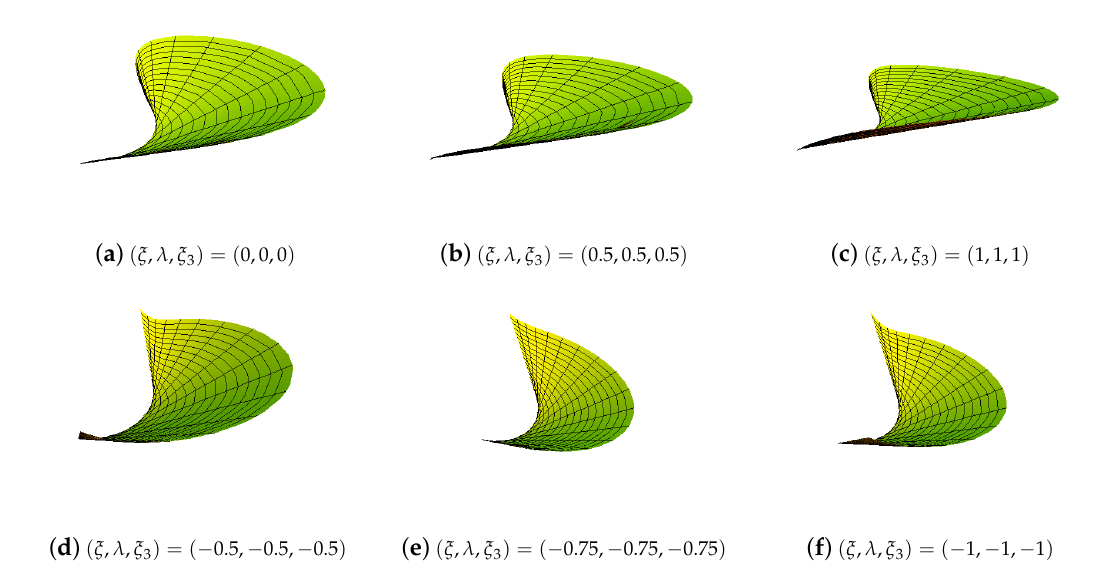
Figure 5. Spine curve developable GHT-Bézier surfaces having same values of ξ , λ , ξ 3 .